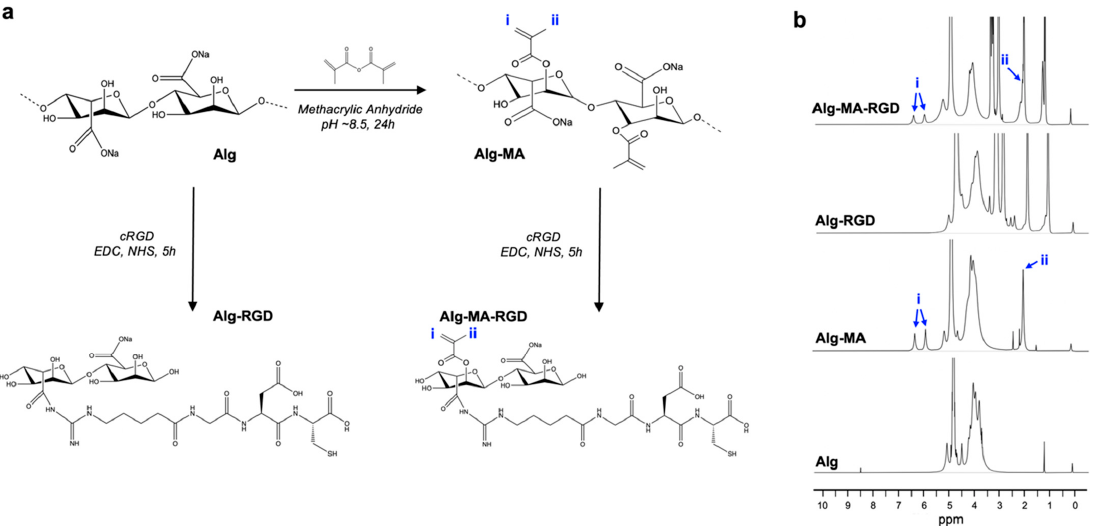
Figure 2. ( a ) Sodium alginate (Alg) was chemically modified with methacrylic anhydride to produce methacrylated alginate (AlgMA). Both Alg and AlgMA were further modified, via carbodiimide chemistry, with the cell adhesion ligand RGD. ( b ) 1 H-NMR spectra of non-modified and modified alginate with and without RGD conjugation. The notations i and ii indicate the proton peaks of vinyl methylene and methyl groups on the functionalized backbone, respectively.